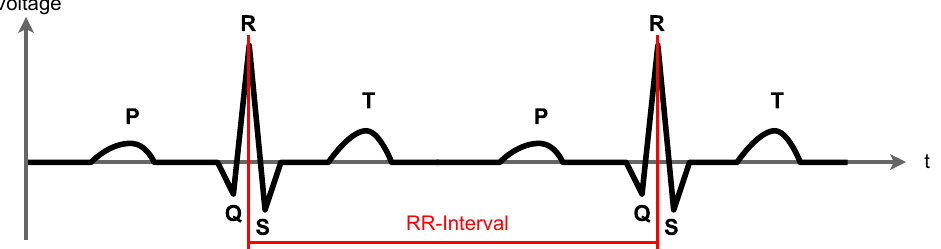
Figure 9. Characteristic ECG voltage curve with an RR interval in red. The R spike is the one with the largest altitude of an interval. It indicates a heart